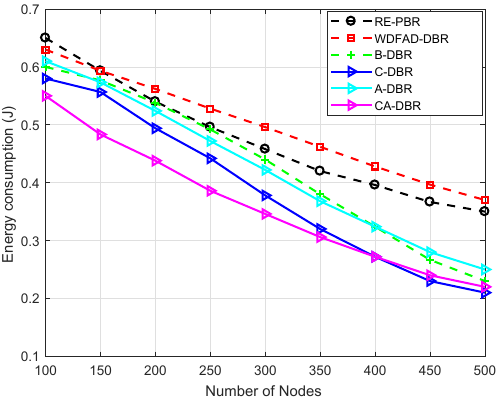
Figure 7. Comparison of energy tax. RE-PBR, Reliable and Energy-efficient Pressure-Based Routing; B-DBR, Backward transmission-based WDFAD-DBR.